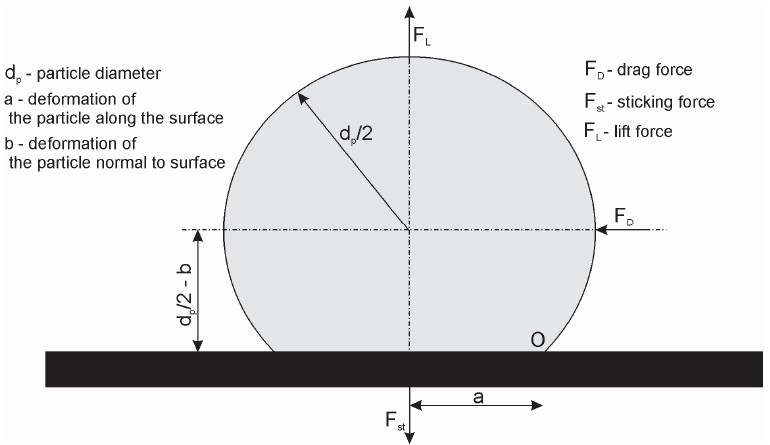
Figure 3. Forces acting on a deformed particle stuck to a wall.